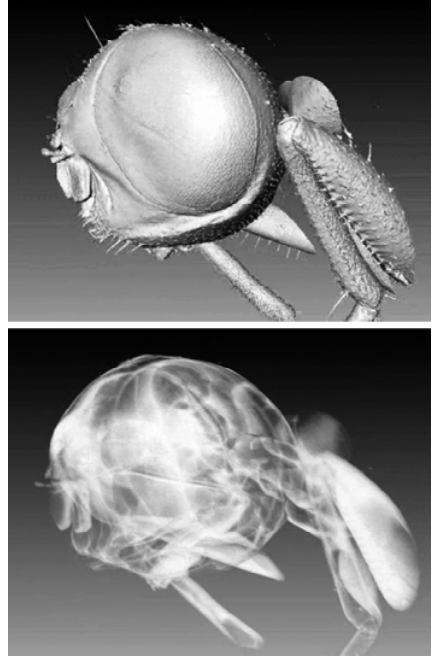
Figure 19. Refractive index microtomography applied to a biological specimen: reconstructed images of the head of a housefly. At the top, a volume image; at the bottom, a “peeled off” rendition of the same